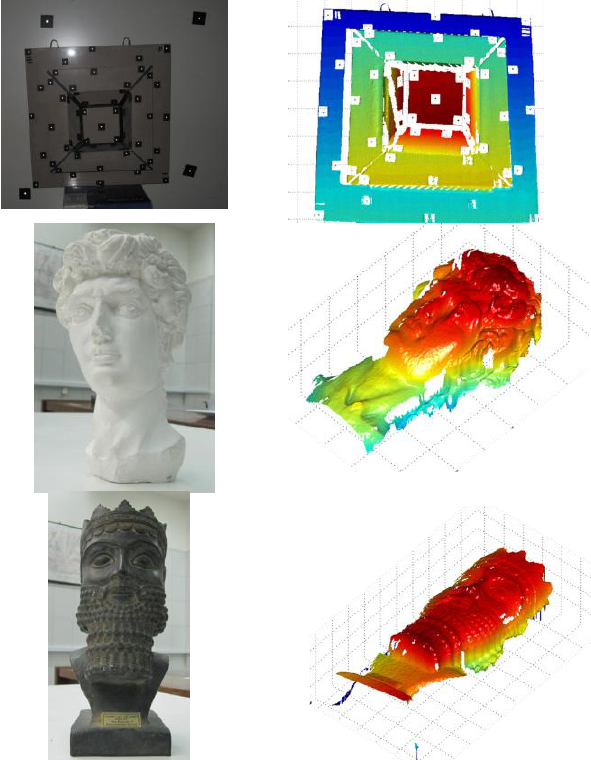
Figure 5. target objects with different material and colours and